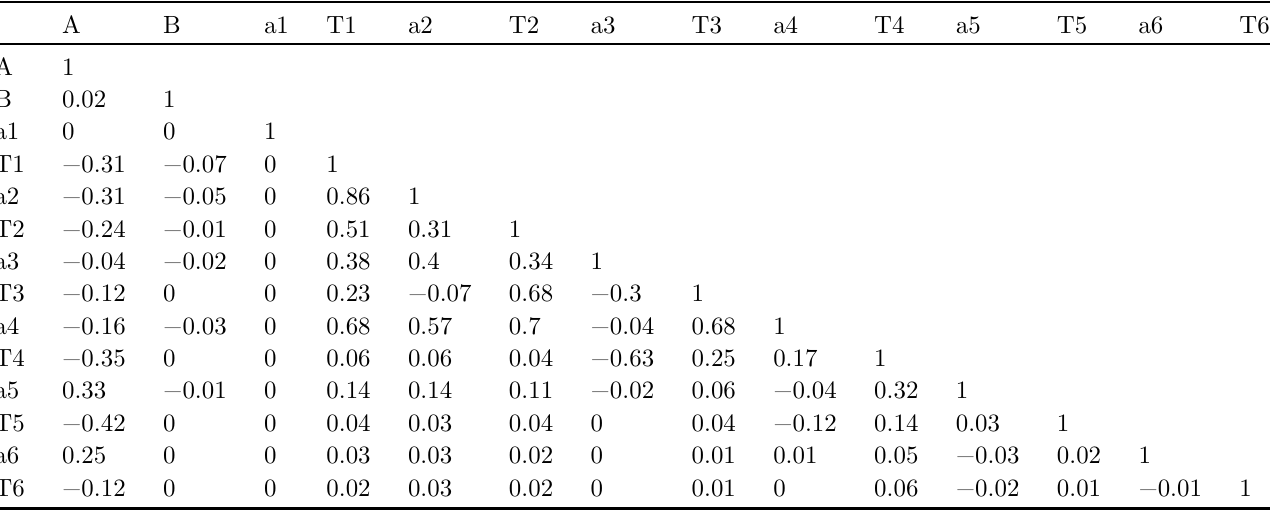
Table A3. Correlation matrix obtained in the result of the steps 1 – 4 (a1 is fi xed).